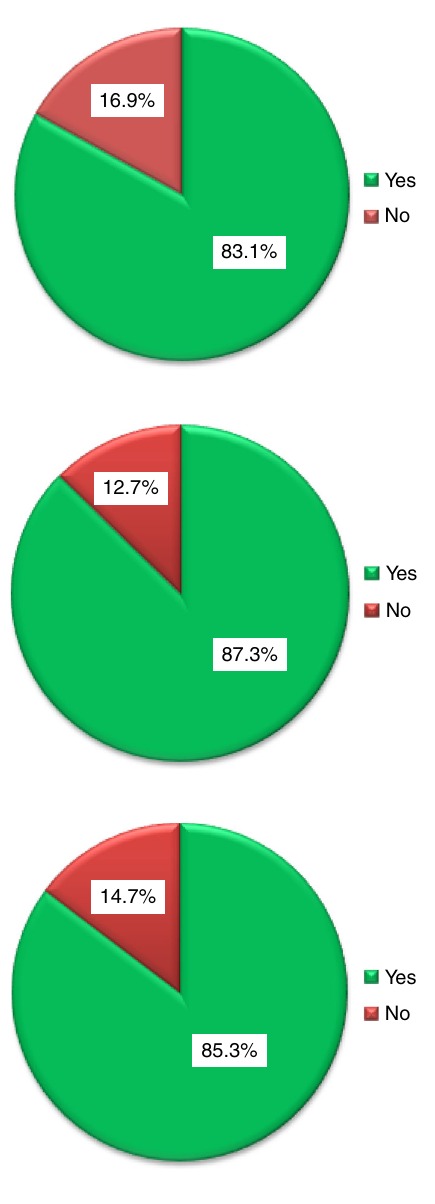
Figure 9. Adopting a semester system